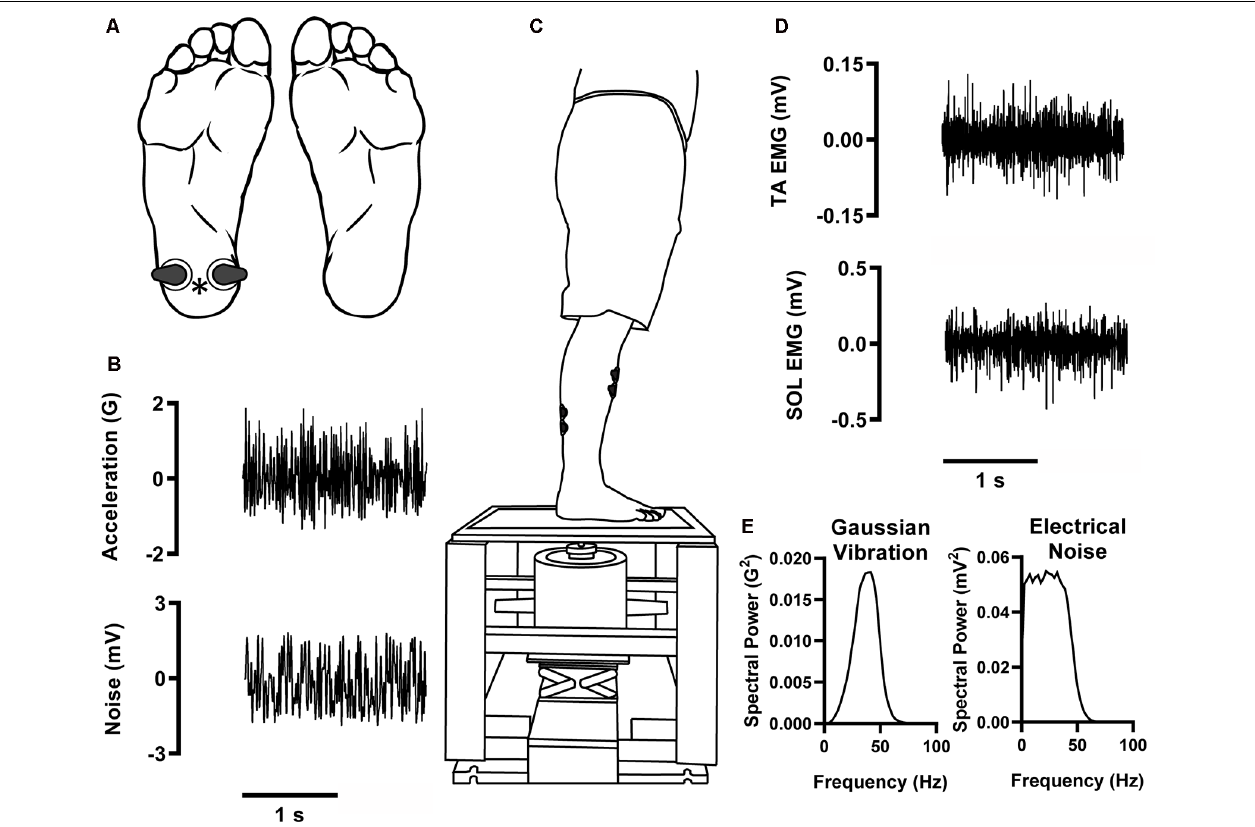
FIGURE 1 | Experimental setup. Participants stood on a custom-built platform with a slight anterior lean (C) . Two-second data excerpts of input stimuli from a 120-s trial. Gaussian vibration stimuli [ B , intensity:10 × perceptual threshold (PT); E , spectral power] were applied to the plantar heel of the right foot (indicated by *) to evoke cutaneous reflexes (A) . Electrical noise stimuli were concurrently applied at intensities between 0% and 100% PT ( A , location; B , two-second waveform excerpt; E , spectral power). (D) Two-second data excerpts of recorded electromyography (EMG) signals from a 120-s trial. EMG was recorded from the soleus (SOL) and tibialis anterior